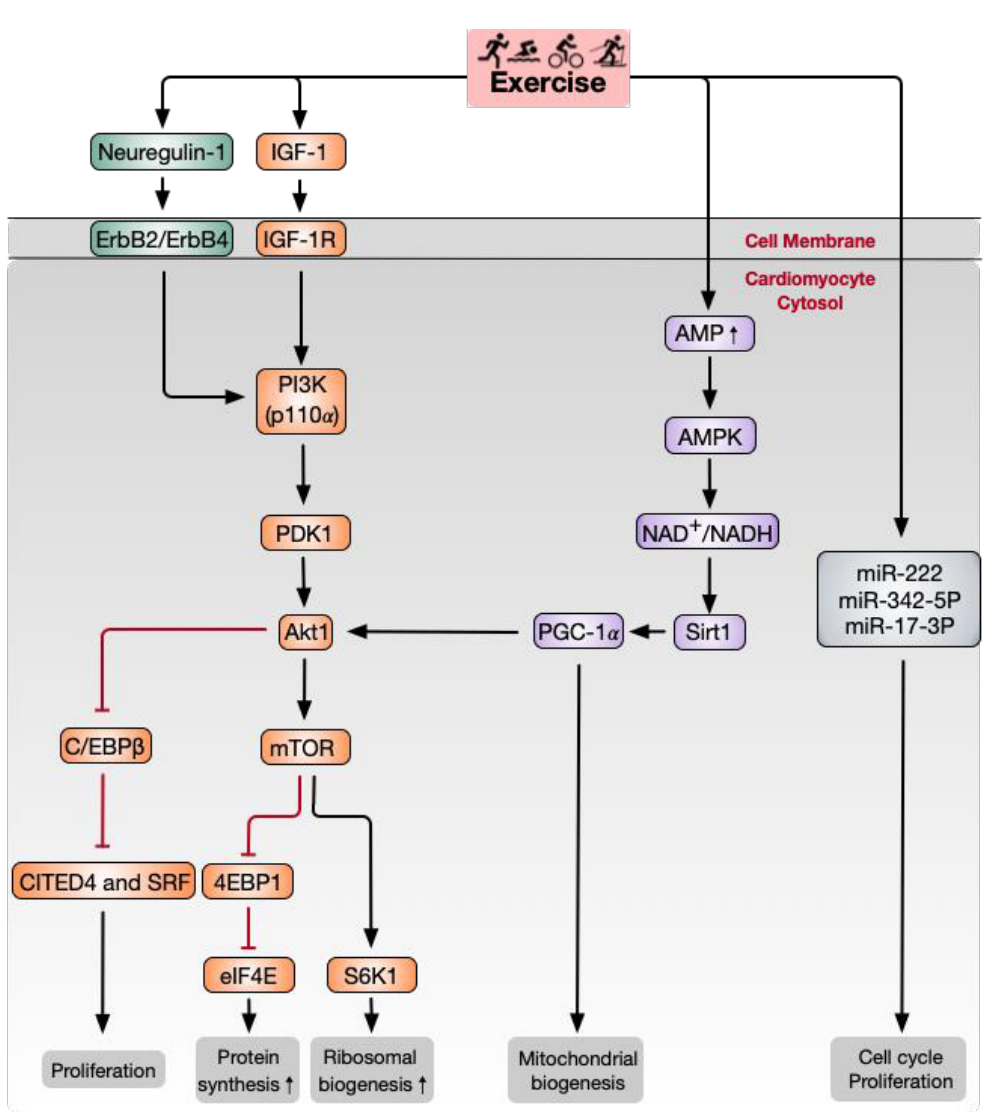
Figure 2. Schematic of major signaling pathways and other factors involved in aerobic exercise-induced cardiomyocyte regeneration. IGF-1 and neuregulin-1 activate PI3K and downstream Akt signaling pathways. Akt activates 4EBP1 and S6K1, downstream signaling molecules of mTOR, which act as crucial factors governing protein biosynthesis in the process of cardiac growth. C/EBP β and downstream CITED4 are activated by Akt1 and are responsible for cardiomyocyte proliferation. Sirt1 and PGC-1 α promote mitochondrial biogenesis. MiR-222 and miR-17-3p have also been shown to regulate the cell cycle and cardiomyocyte proliferation. Akt, RAC- α serine/threonine-protein kinase; C/EBP β , CCAAT/enhancer-binding protein- β ; CITED4, CBP/p300-interacting transactivator with ED-rich carboxy-terminal domain-4; eIF4E, translation initiation factor 4E; IGF-1, insulin growth factor-1; mTOR, mammalian target of rapamycin; PDK1, phosphoinositide-dependent protein kinase-1; PGC-1 α , peroxisome proliferator-activated receptor- γ coactivator 1 α ; PI3K, phosphoinositide 3-kinase; Sirt1, NAD-dependent deacetylase sirtuin1; S6K1, ribosomal protein S6 kinase- β 1; 4EBP1, eIF4E-binding protein 1.